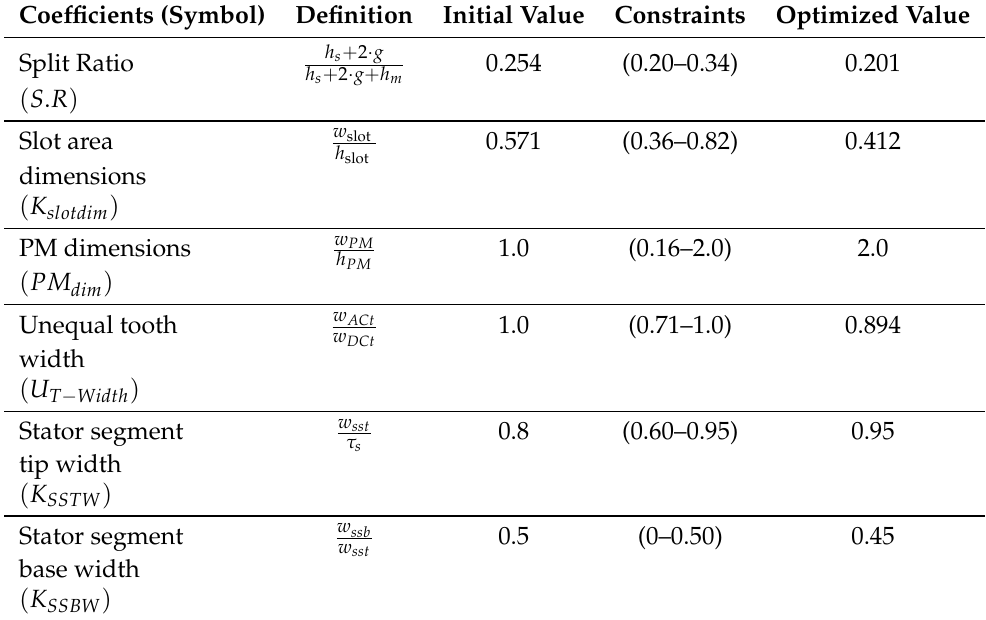
Table 2. Optimization